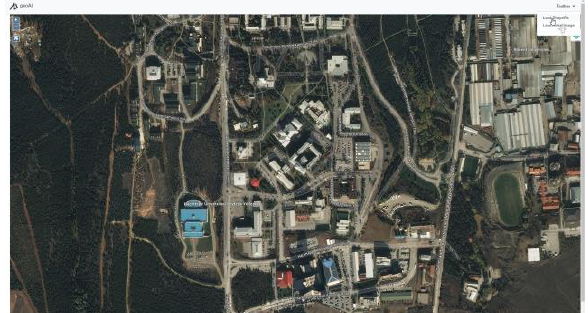
Figure 3. WebGIS interface elements of the developed GeoAI platform.